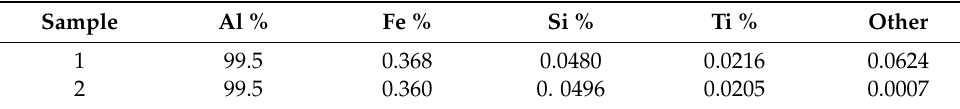
Table 1. Chemical composition of AA 1050-H14 sheets.